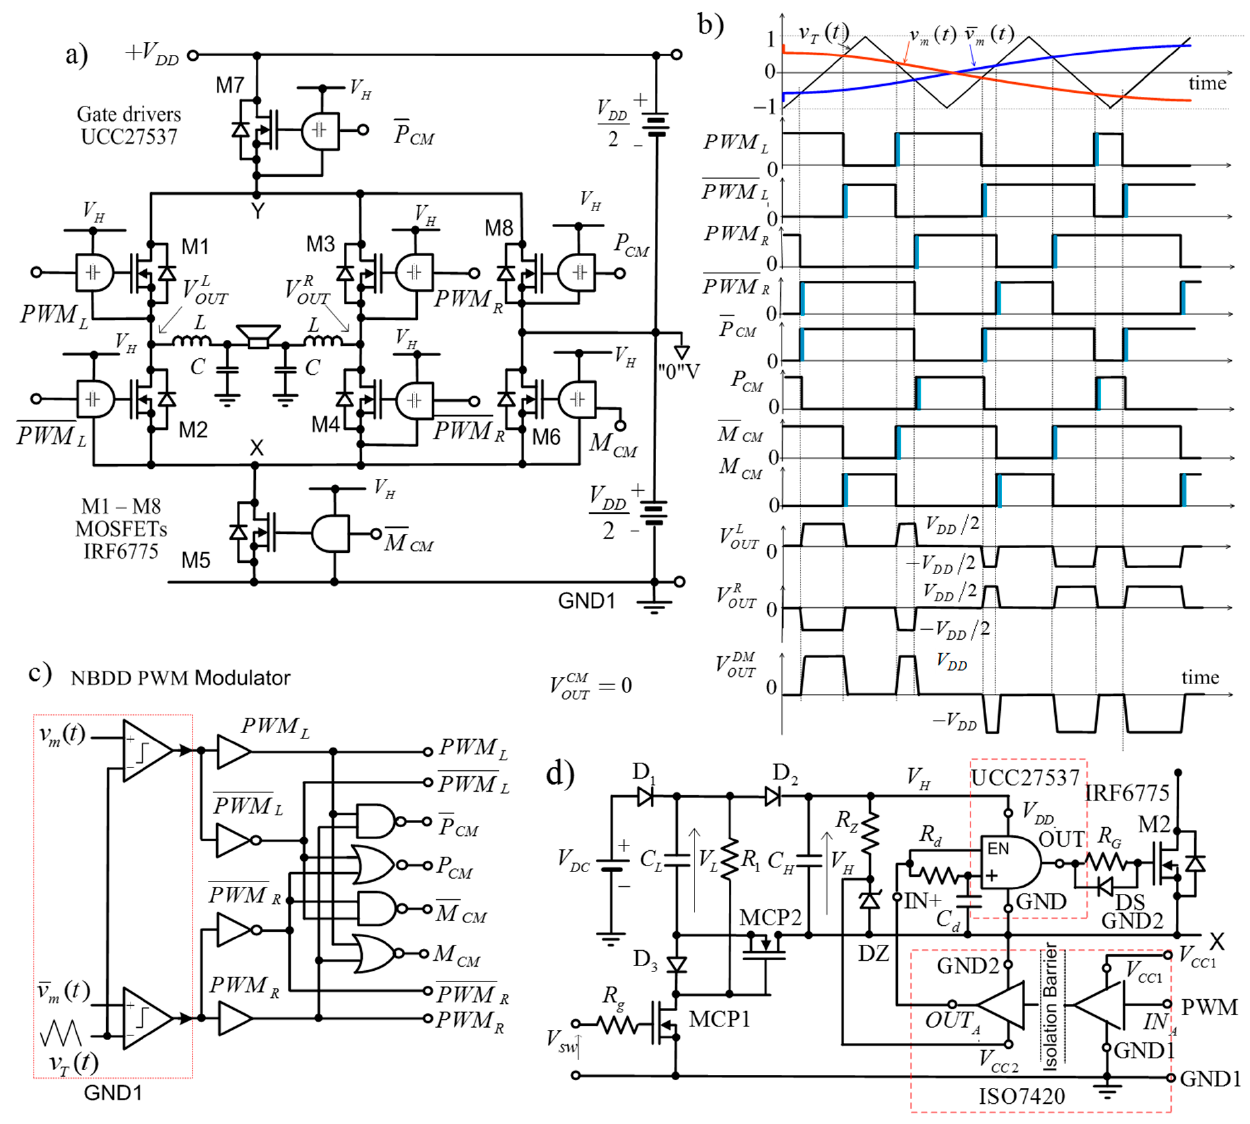
Figure 3. Class-BD audio amplifier with balanced CM output, using the extended NBDD PWM modulator: ( a ) Topology of the output stage, ( b ) time domain waveforms at the outputs of the modulator and amplifier. ( c ) Block diagram of the extended NBDD PWM modulator. ( d ) Floating gate driver with galvanic isolation of the control signal.